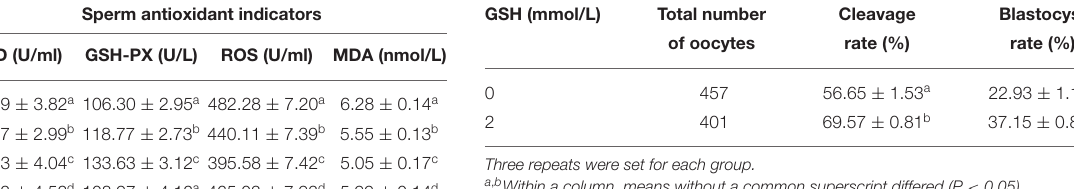
TABLE 3 | Effect of glutathione (GSH) on sperm antioxidant indicators of Guanzhong dairy goats after thawing. GSH (mmol/L)